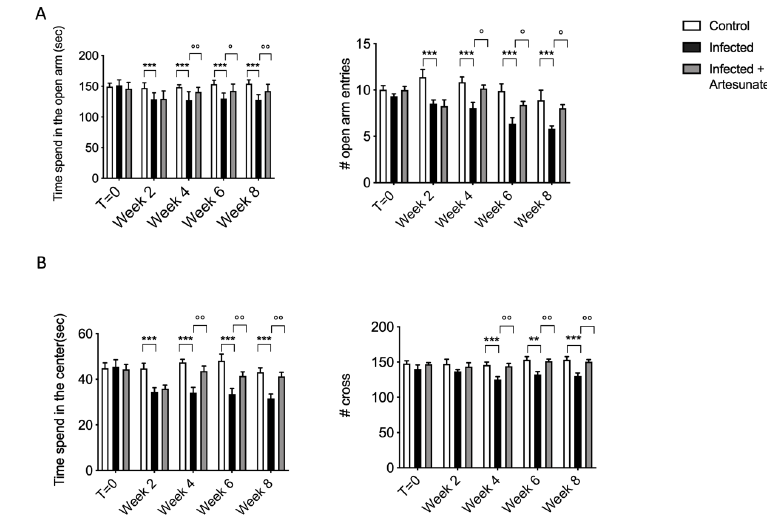
Figure 2. ( A ) An elevated plus maze test showed a significant decrease in time spent on open arms and number of open arm entries for the infected group compared to the control group. Treatment with artesunate significantly increased time spent on open arms and number of open arm entries compared to infected group. ( B ) An open field test showed a significant decrease in time spent in the